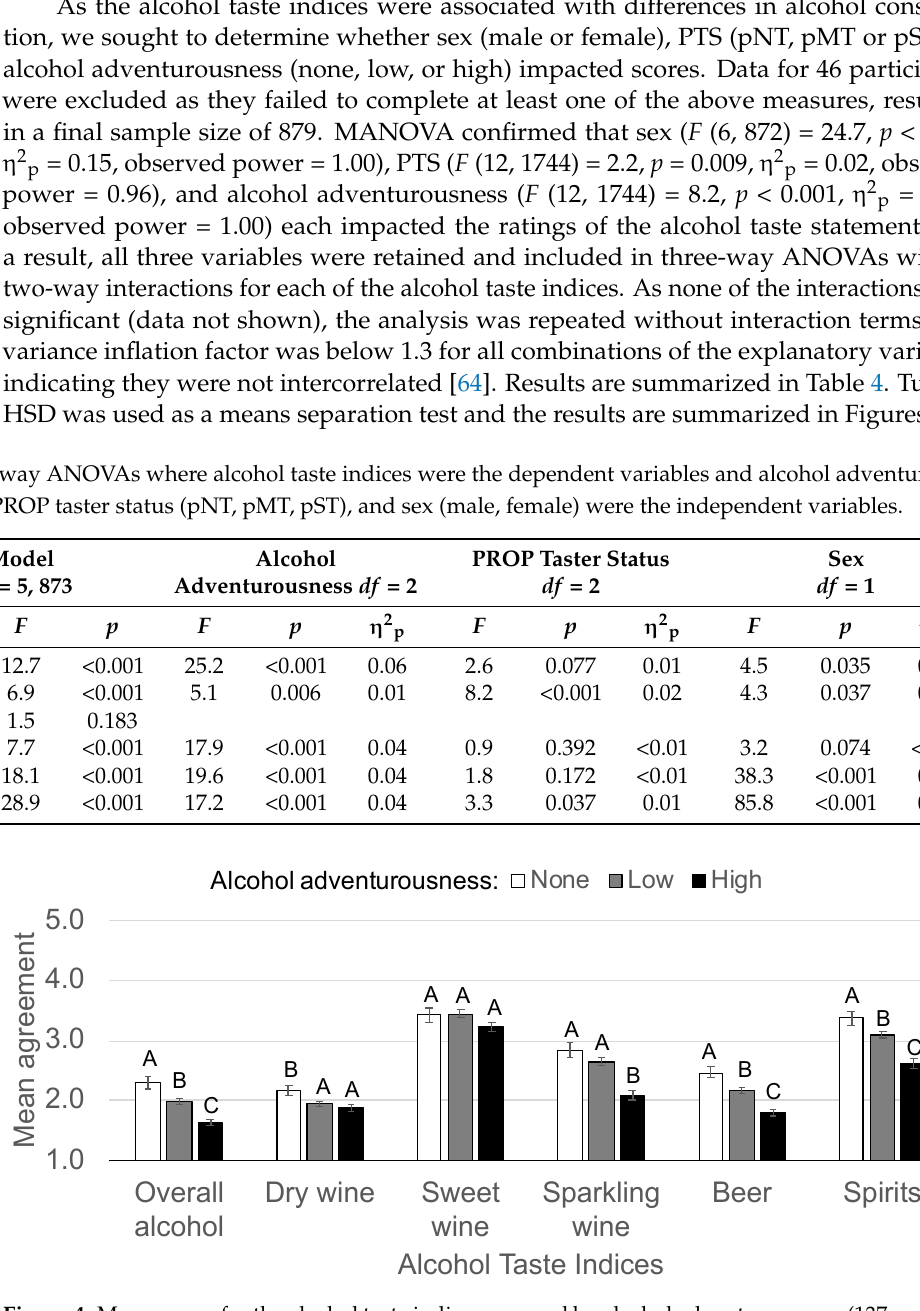
Figure 5. Mean scores for the alcohol taste indices grouped by PROP taster status (255 pNT, 459 pMT, 165 pST). Significantly different means from three-way ANOVAs indicated with different let- ters. Figure 6. Mean scores for the alcohol taste indices grouped by sex (351 male, 528 female). Signifi- cantly different means from three-way ANOVAs indicated with different letters.